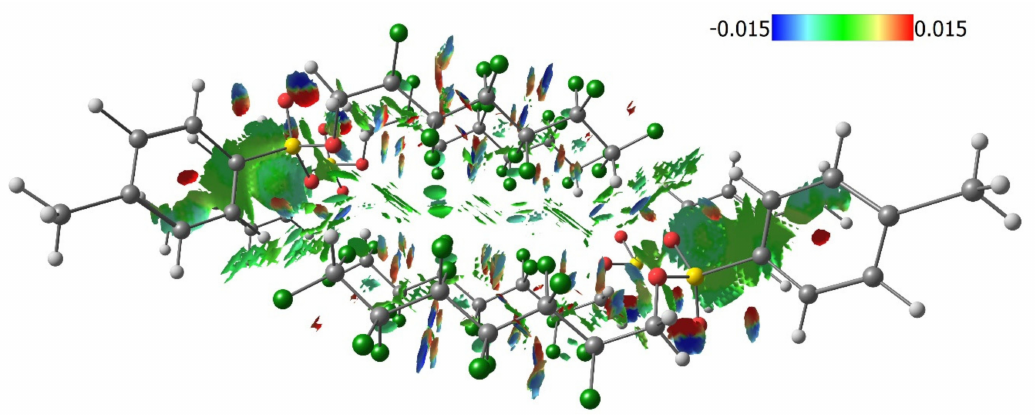
Figure 11. 3D surface of RDG (0.6 a.u.) colored according to sign ( λ 2 ) ρ function in 3a illustrating the interaction between (CF 2 ) 5 CHF 2 groups. Intermolecular interactions between fluorine atoms are shown at middle bottom.